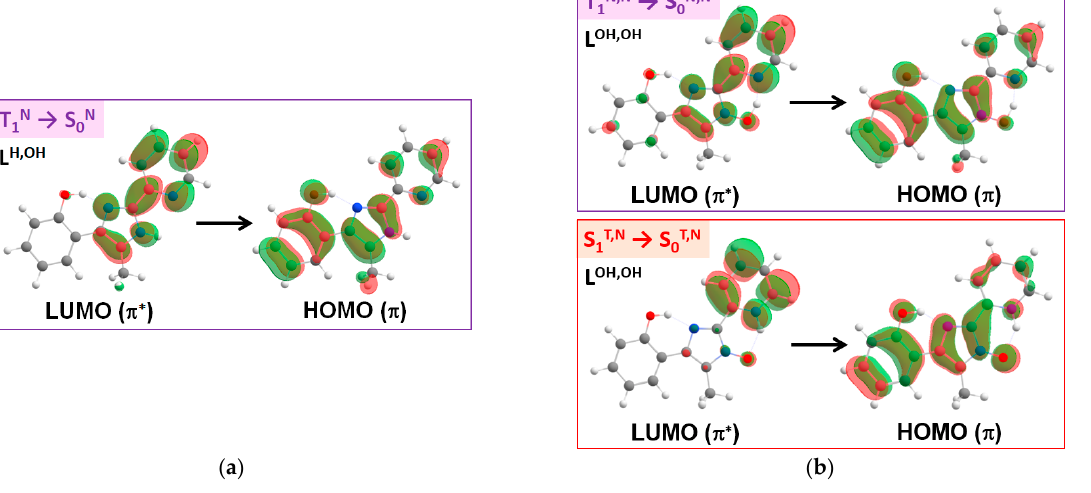
Figure 8. Frontier molecular orbitals related to the emission processes observed for L H,OH ( a ) and L OH,OH ( b ).